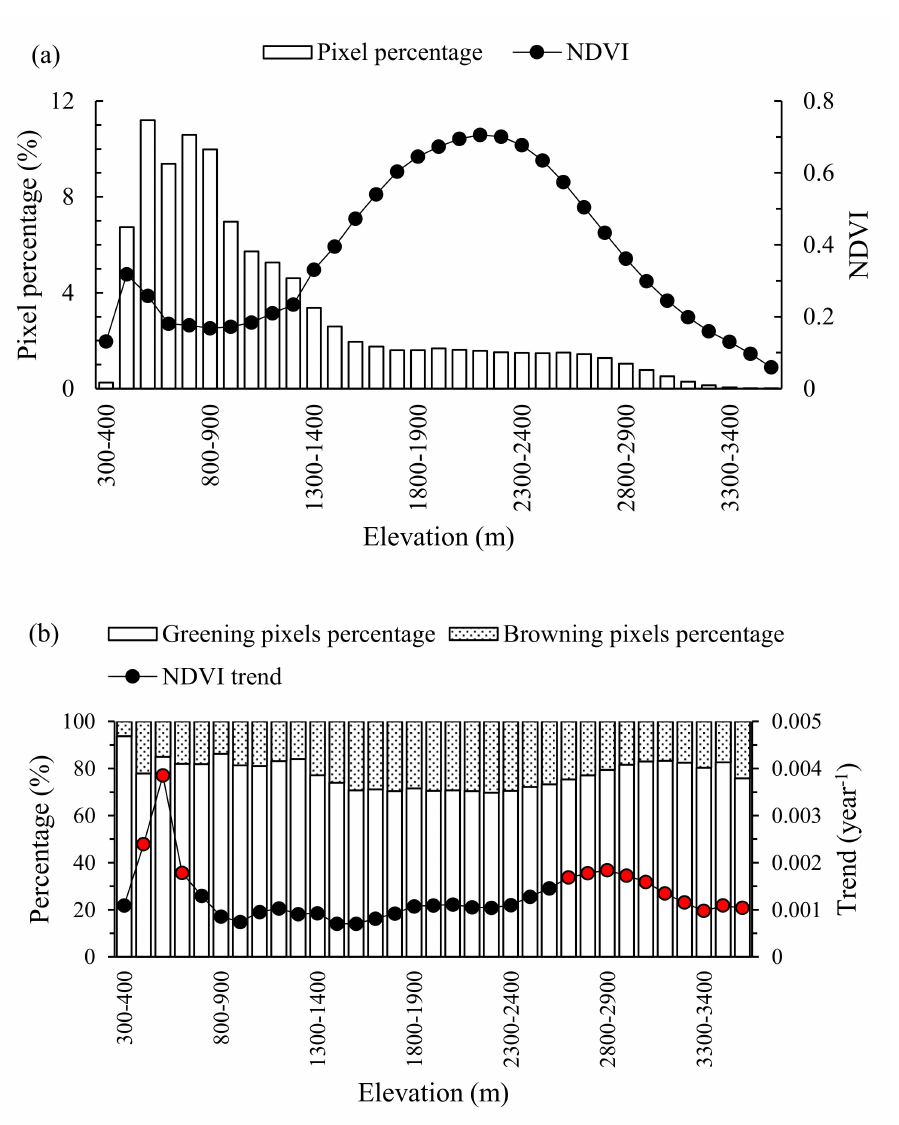
Figure 3. Average NDVI during 2000–2017 for each elevation bin ( a ), and mean NDVI trend for each elevation bin ( b ); the red dots indicate that the trend is statistically significant (p <